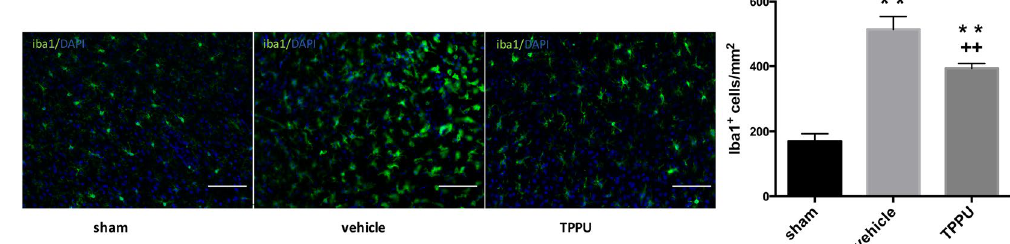
Figure 7. TPPU reduces microglia number in peri-ischemic region. Representative images of Iba1 staining in the peri-ischemic cortex in sham, vehicle, and TPPU-treated groups at day 2 after surgery. Note that enlarged cell bodies in the peri-infarct region of the vehicle group were less prominent in the TPPU group. Scale bar = 50 μ m. The number of Iba1-positive cells was compared among groups by ANOVA and the Holm-Sidak procedure for multiple comparisons (means ± SD; n = 5 rats per group; ** p < 0.01 vs. sham group; ++ p < 0.01 vs. vehicle group).